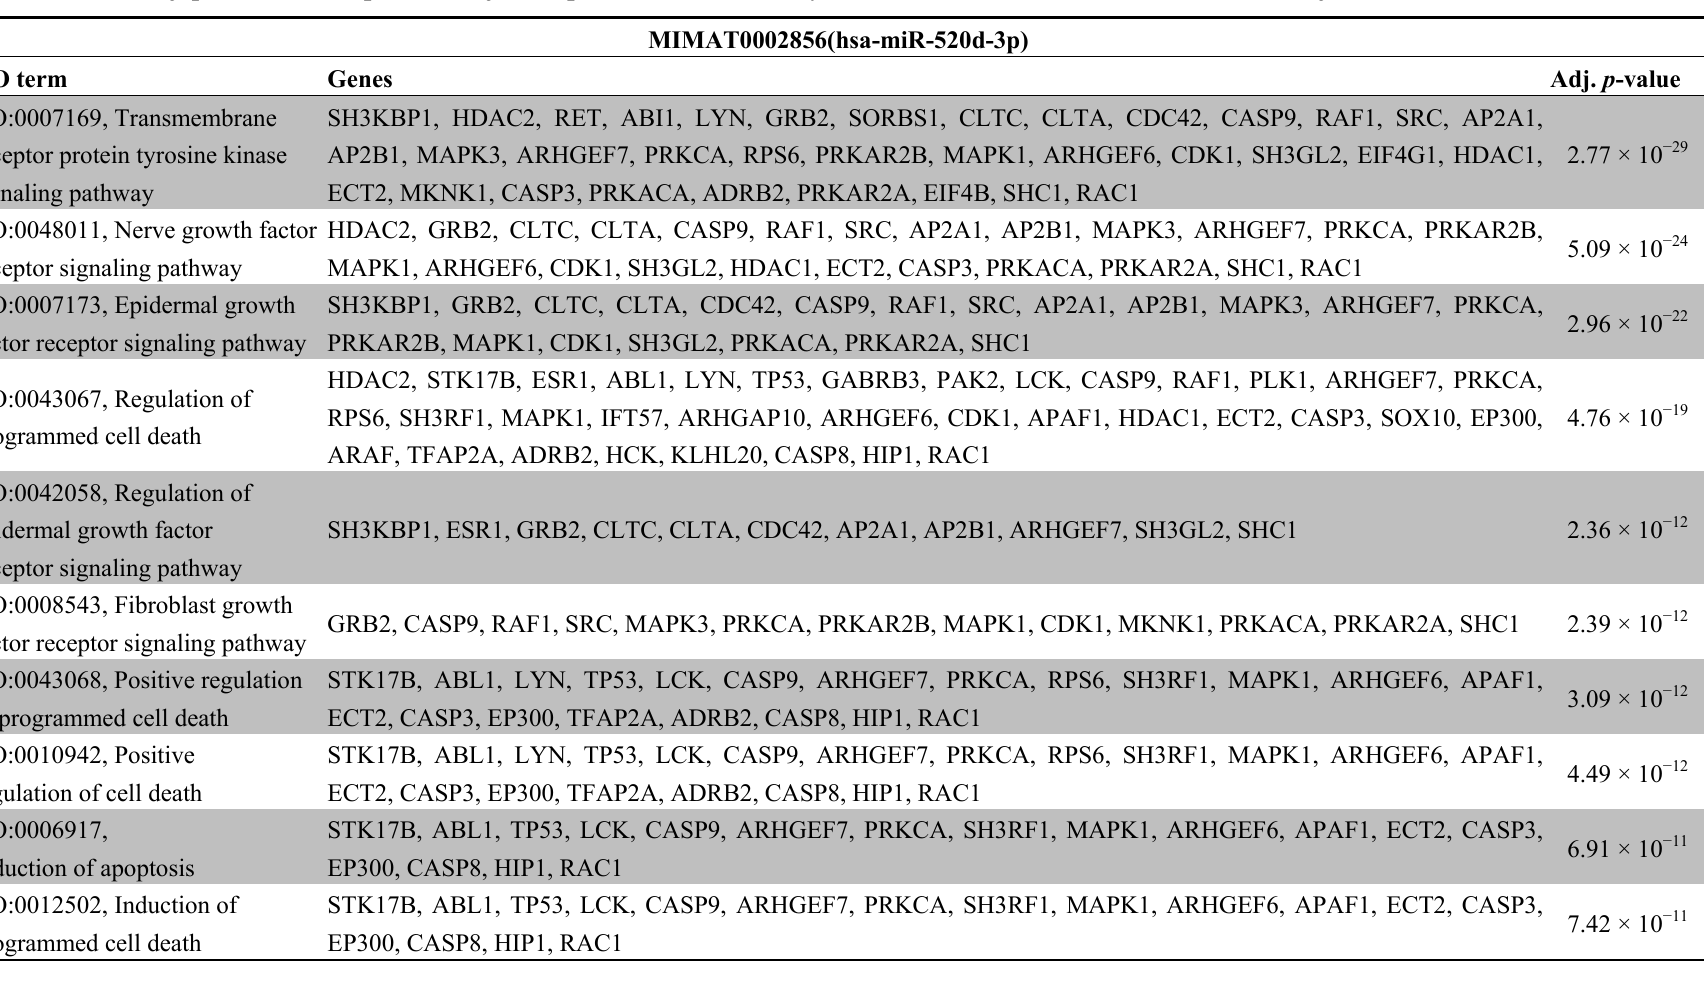
Table S6. Specific enriched GO terms of each miRNA-regulated PINs. Genes annotated with the specific GO term in the PIN were also listed in this table. Adj. p -value: multiple-test adjusted p-value calculated by the method described in the work of Benjamini and Yekutieli